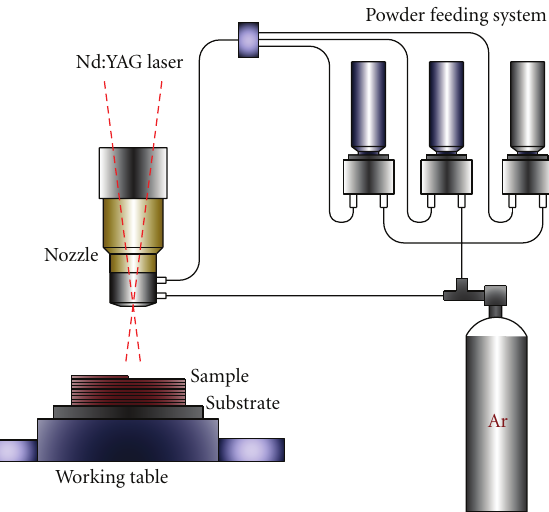
Figure 2: Schematic of of LENS